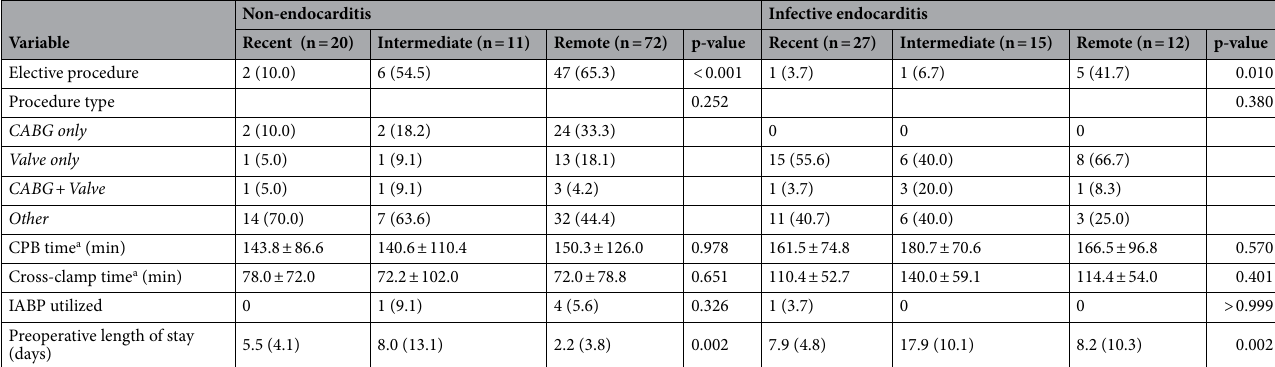
Table 2. Intraoperative details by endocarditis cohort and stroke timing subgroup. Values are expressed as number (%) unless otherwise indicated. CABG coronary artery bypass grafting, CPB cardiopulmonary bypass, IABP intra-aortic balloon pump. a Mean ± standard deviation.